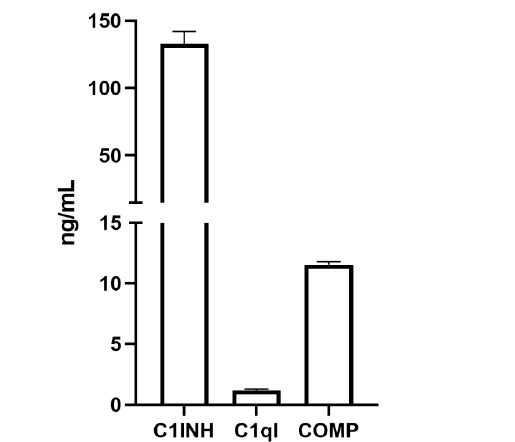
Figure 9. Mouse Sertoli cells express and secrete protein for complement inhibitors. Mouse SCCM was analyzed for protein levels of the complement inhibitors C1INH, C1qI, and COMP. C1INH was detected at 133.065 ± 9.001 ng/mL, C1qI was detected at 1.205 ± 0.092 ng/mL, and COMP was de- tected at 11.560 ± 0.231 ng/mL.